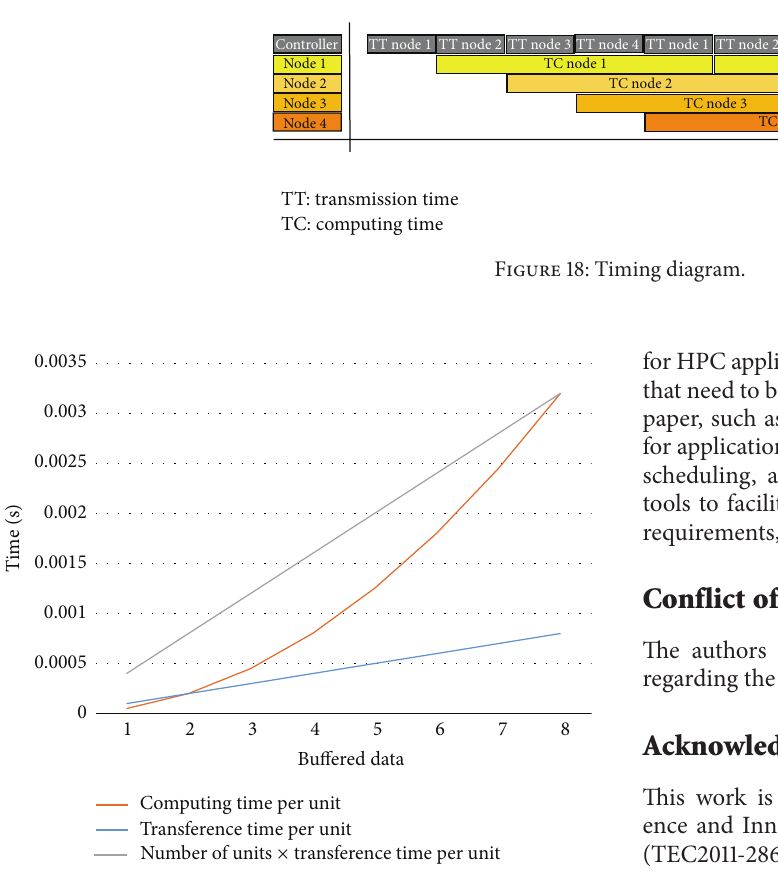
Figure 19: Computing versus transference time ( 5000 ×5000 4 4 × 4